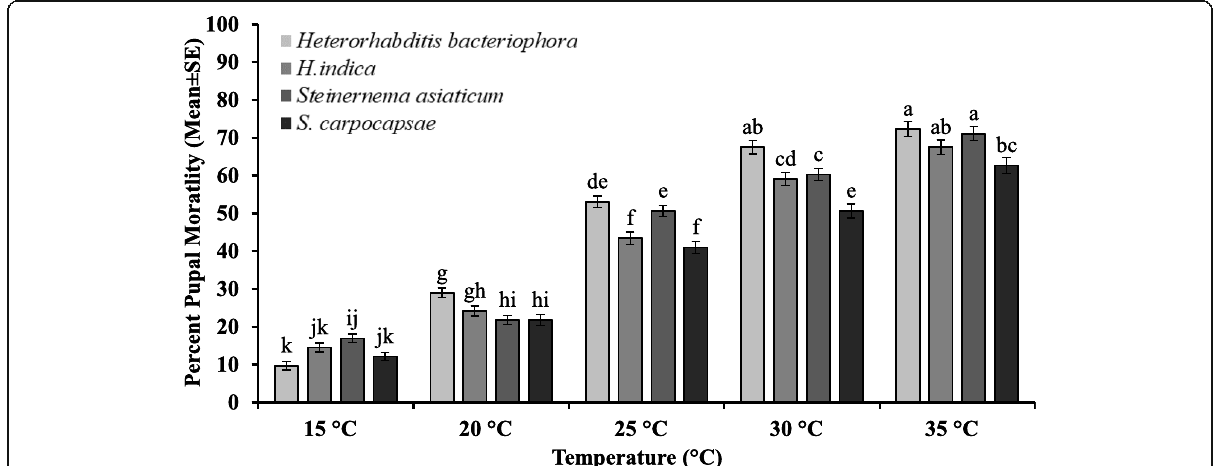
Fig. 1 Pupal corrected percent mortality (mean ± SE) in Bactrocera dorsalis , 10 days post exposure to EPNs at different temperature degrees (DF = 12, F = 9.20, P = 0.00; Tukey ’ s HSD test, α =